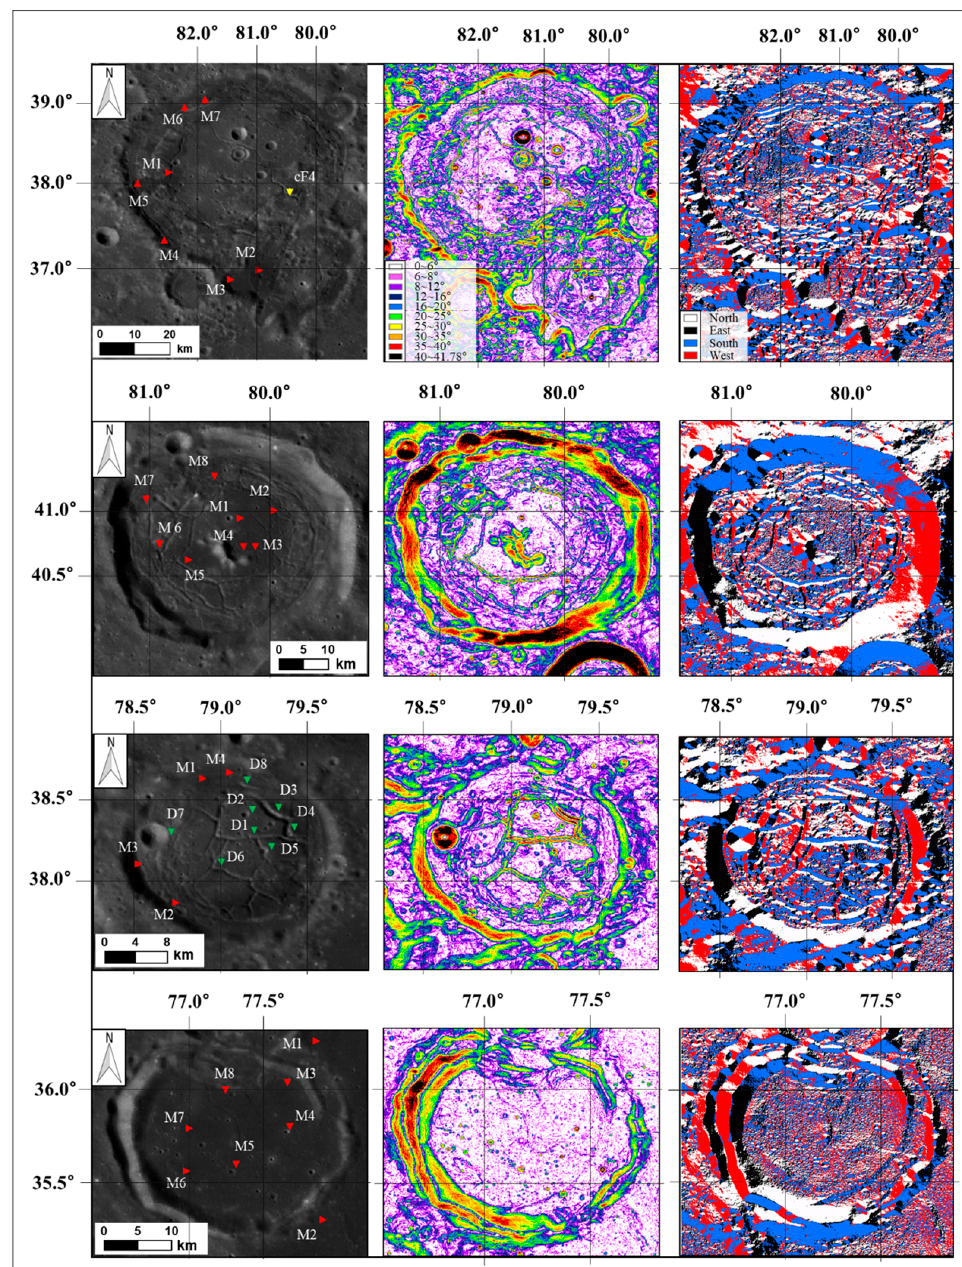
Figure 10. The WAC base map ( left ), the slope analysis ( middle ), and the aspect analysis ( right ) using the SLDEM2015 dataset of our study area. The points each for crater indicate the mare basalts, the dark mantle deposits, and the crater floor. The cF4 in the Lavoisier Crater is located near the dark mantle deposits. The colors in the slope analysis represent the range of slope degree: white (0~6°), pink (6~8°), purple (8~12°) navy (12~16°), blue (16~20°), green (20~25°), yellow (25~30°), orange (30~35°), red (35~40°), and black (40~71.48°). The right images show the direction of the slope in colors: white—north (315~360° and 0~45°), black—east (45~135°), blue—south (135~225°), and red—west (225~315°).